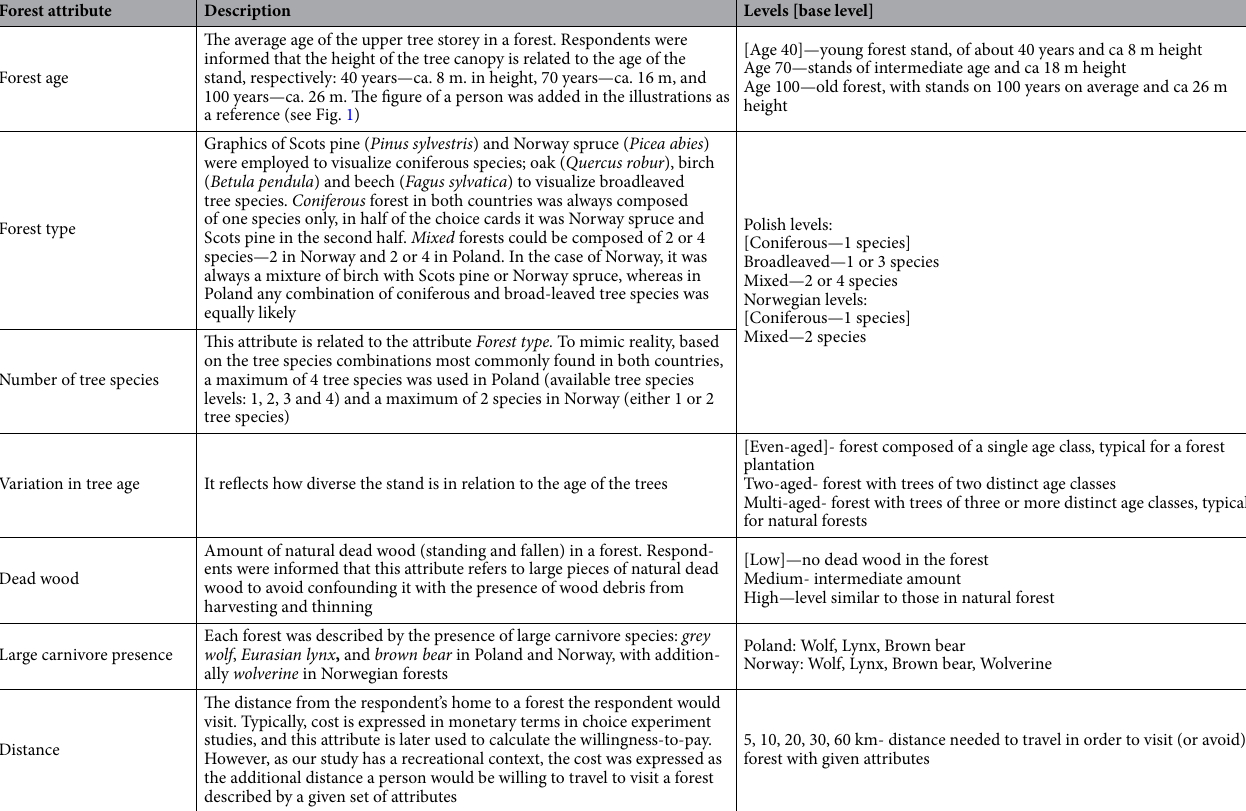
Table 1. Attributes and levels used in choice experiments to investigate public forest preferences in Poland and Norway. The reference level for the statistical analysis is indicated in